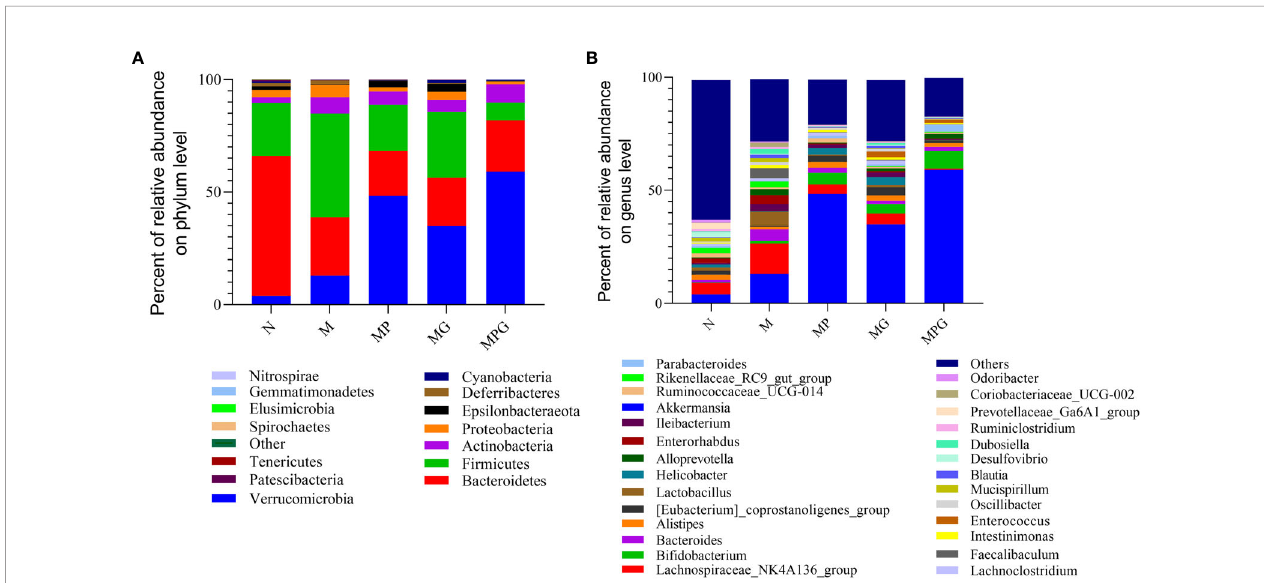
FIGURE 4 | The effect of live culture of Enterococcus faecium and Bacillus subtilis (LCBE) and galacto-oligosaccharides (GOS) on murine microbial composition. (A) Relative abundance of bacteria at phylum level; (B) Relative abundance of bacteria at genus level under different treatments. The ordinate represents the species name, the color gradient indicates the proportion of the